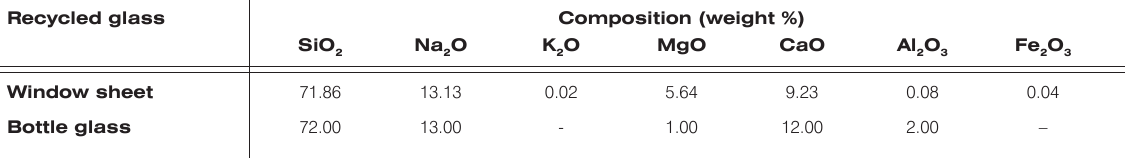
Table 1. Oxidic composition of the recycled glasses used as precursors. Recycled glass